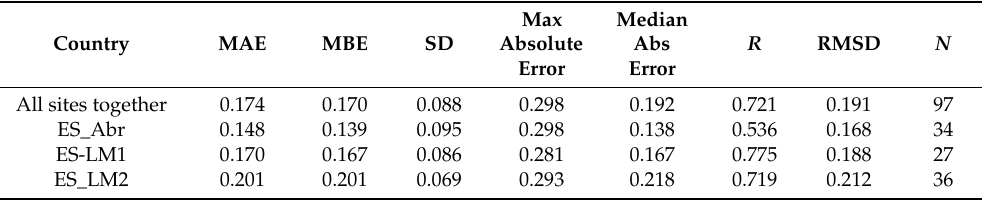
Table 4. Summary of EF comparisons with Fractional Vegetation Cover (Fr) for all the experimental sites and all the studied